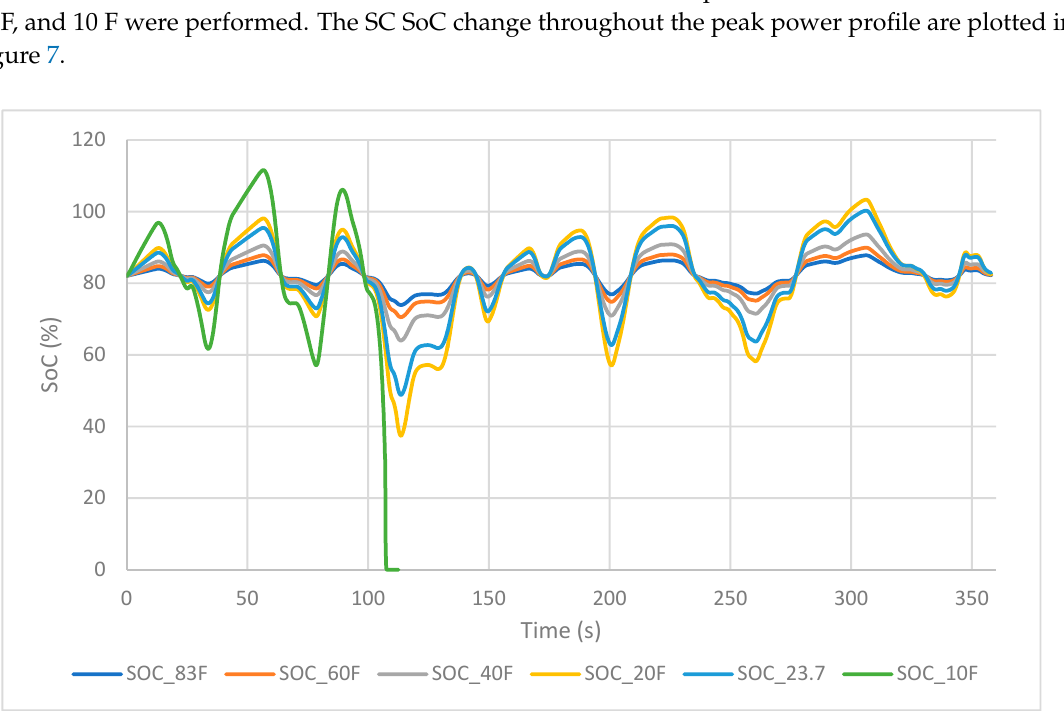
Figure 7. SoC change with different SC size of the peak power profile.